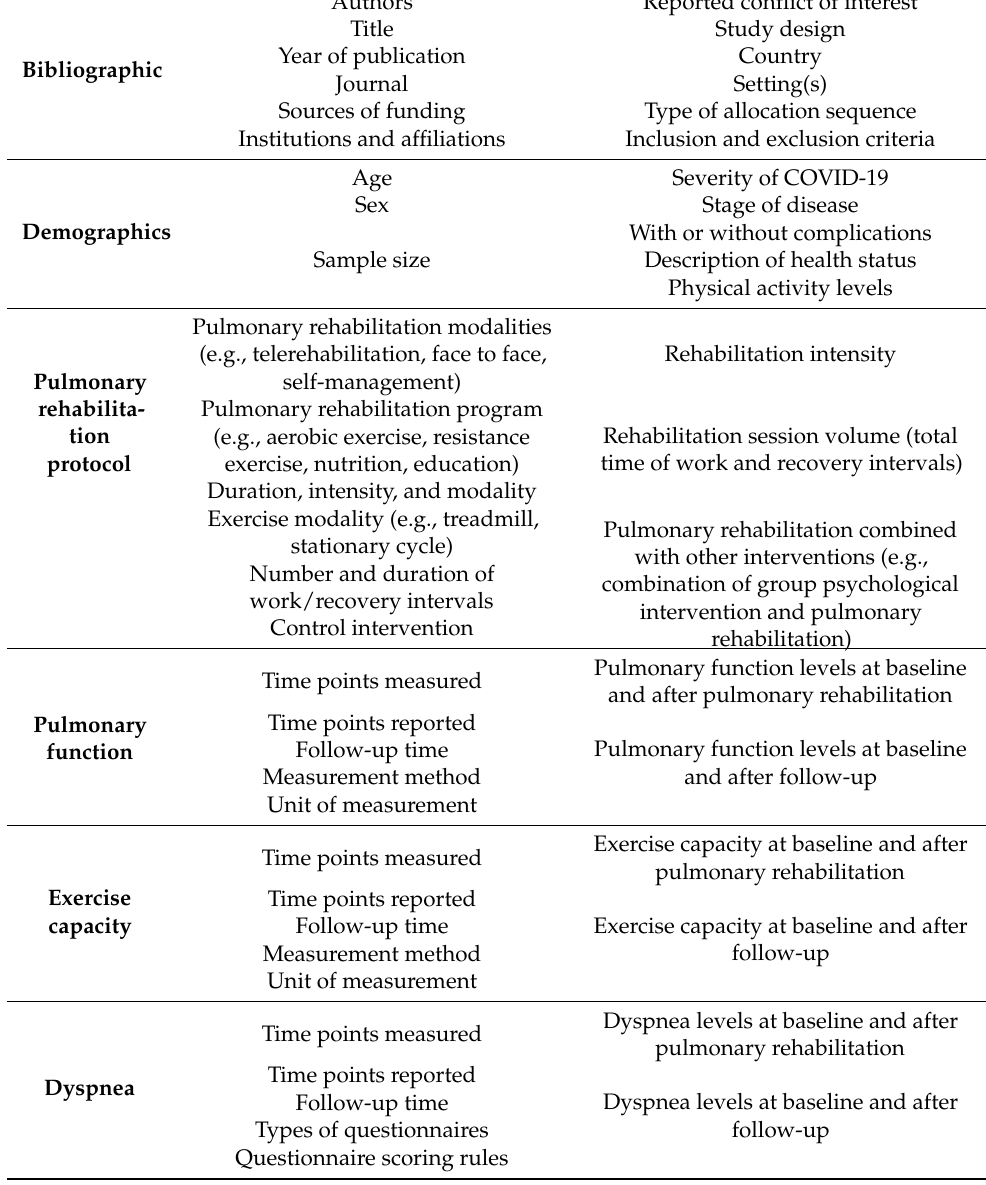
Table 3. Variables to be extracted at the full-text